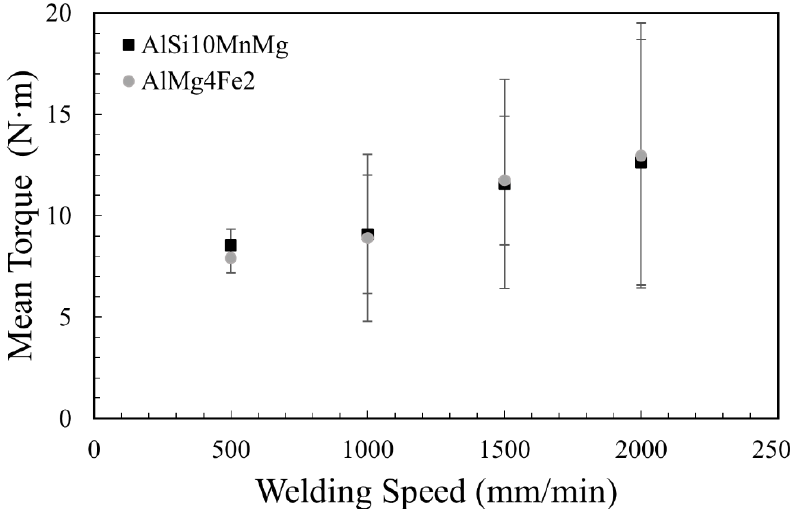
Figure 13. Mean torque as a function of welding speed for AlSi10MnMg and AlMg4Fe2 welds .